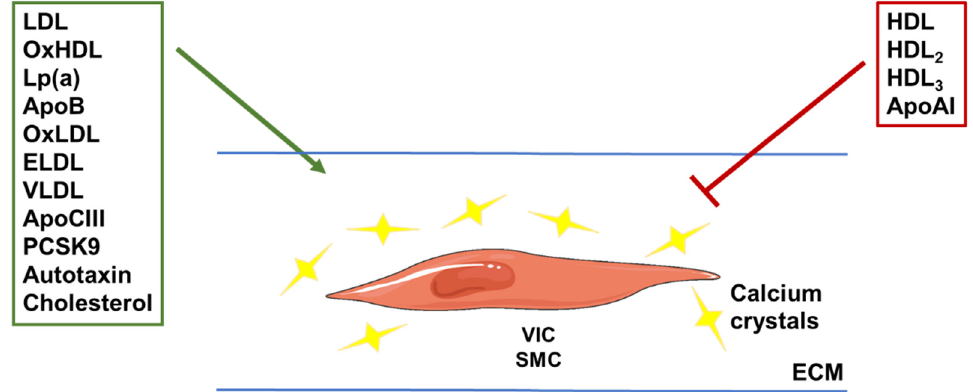
Figure 3. Illustration of the roles of different (apo)lipoproteins in vascular calcification. VLDL and LDL lipoprotein subfractions, and their oxidized or enzyme ‐ modified forms (OxLDL and ELDL), were shown to stimulate calcium crystal deposition. Components of these particles, such as apoCIII, apoB and cholesterol, were also linked to increased calcification. The same was shown for Lp(a) and the enzyme autotaxin carried by these particles. The hepatic enzyme PCSK9 was shown to stimulate vascular calcification by increasing LDL concentrations through degradation of the LDL receptor. HDL subfractions and the main apolipoprotein found in these particles (apoAI) were shown to reduce calcification, although the oxidized form of HDL (OxHDL) was shown to do the opposite. VIC: valvular interstitial cell; SMC: smooth muscle cell; ECM: extra ‐ cellular matrix.